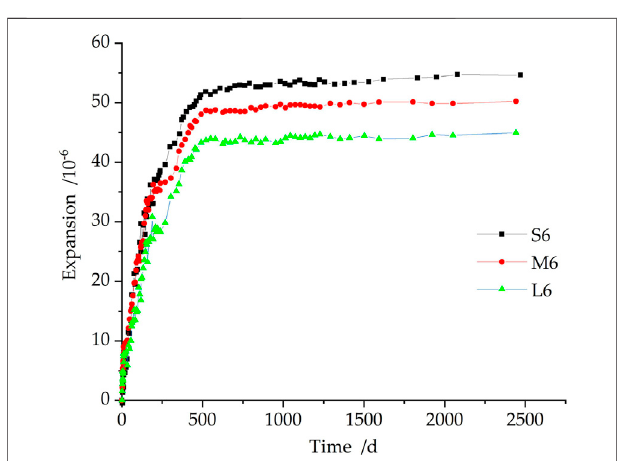
FIGURE 5 | Autogenous volume deformation of long-aged concrete mixed with 10% MgO at different specimen